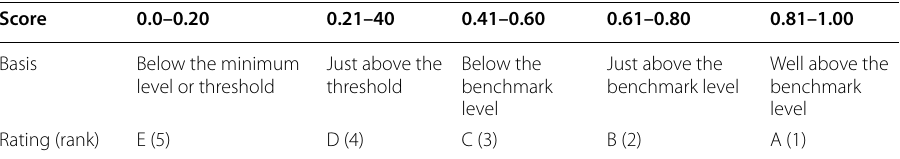
Table 10 The 5-point rating